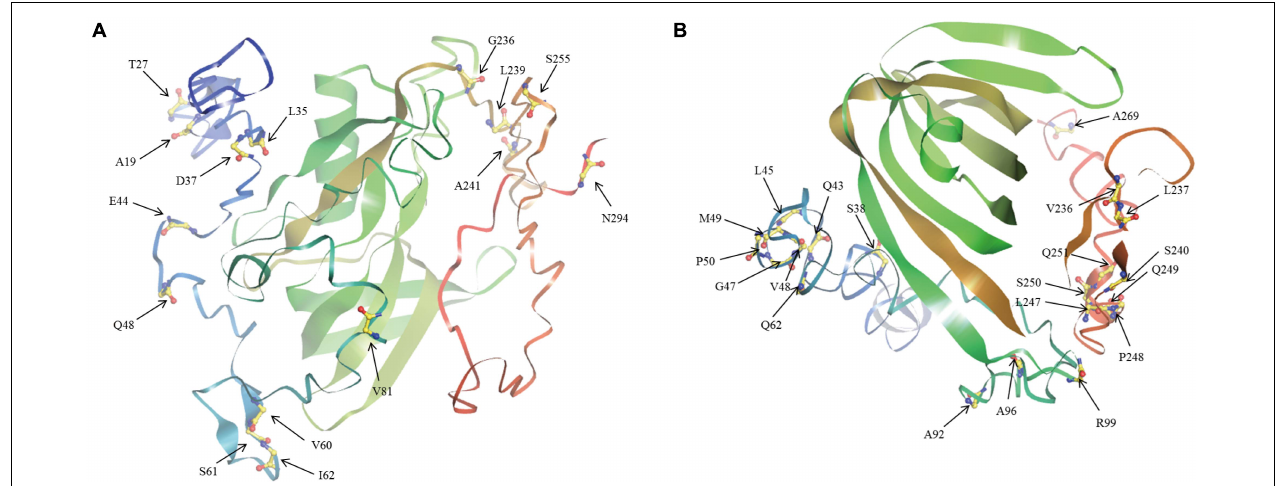
FIGURE 6 | The tertiary structure of BnaAHL proteins. This is a schematic diagram of the tertiary spatial structure of the BnaAHL13j (A) and BnaAHL13g (B) , which are the Type-II and Type-III protein query sequence, respectively. The arrow points to the amino acid of positive selection.